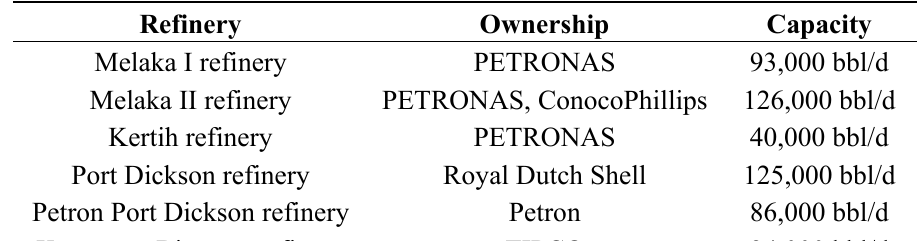
Table 9. List of refineries in Malaysia.